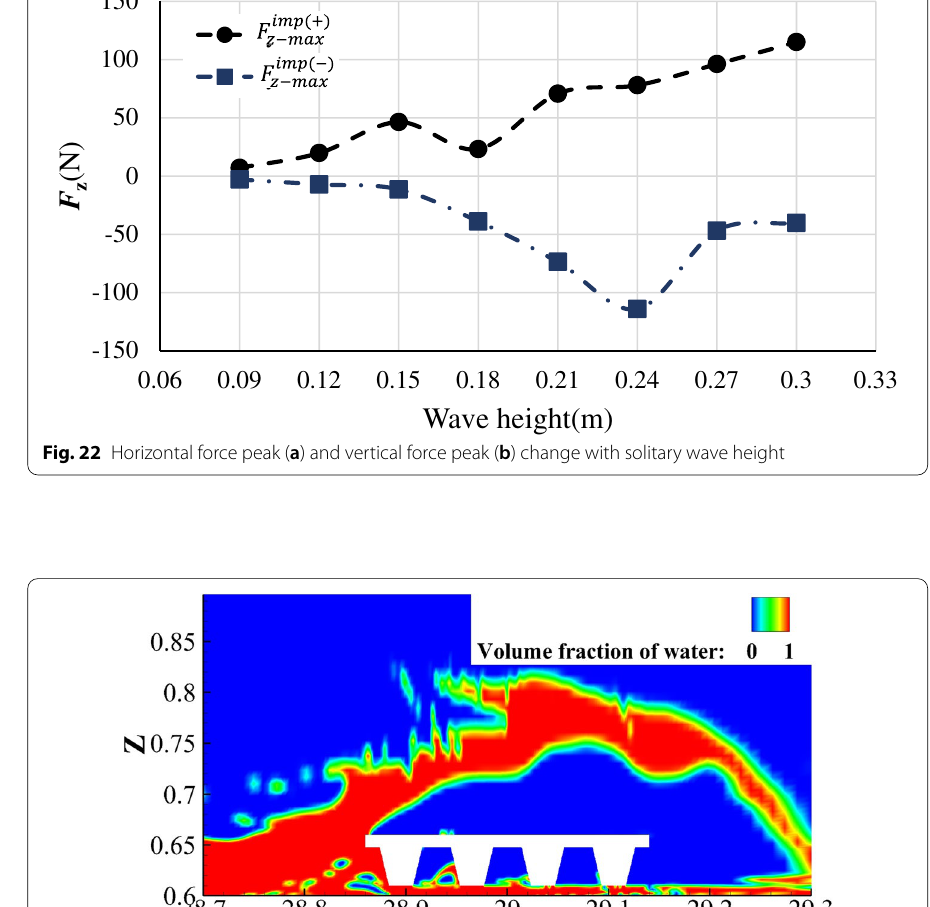
12.83 s when water tongue partly strides over the bridge deck, a =